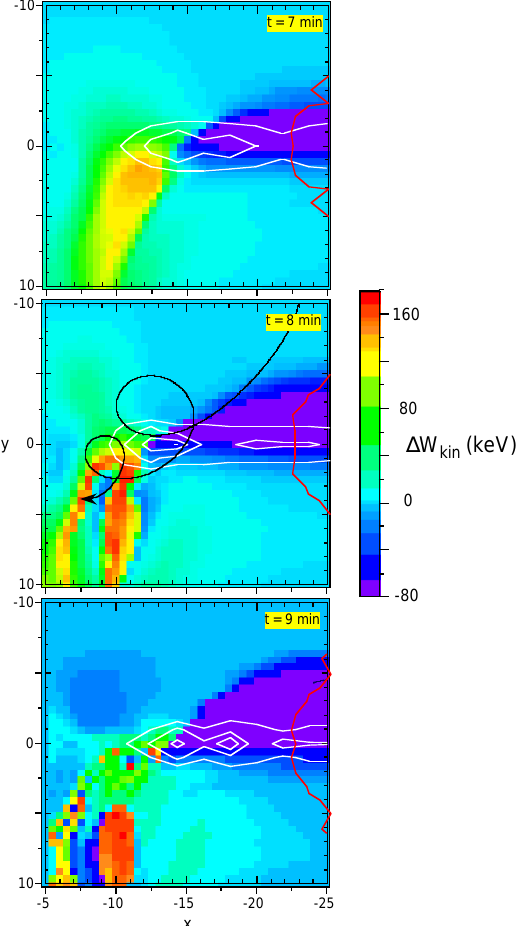
Fig. 4. Characteristics of earthward 180keV O + fluxes in the equa- torial plane for t = 7 , 8 , 9min. The color-coding again represents the energy gain of an ion traced backwards from the given loca- tion, taken as a measure of the flux increase at the given location. The white contours represent the magnitude of the cross-tail electric field, and the red line shows the magnetic neutral line as in Fig. 2. The black line with an arrow at the end represents a typical orbit with substantial energy gain. The bottom panel is identical to the earthward part of the third panel in Fig. 2.